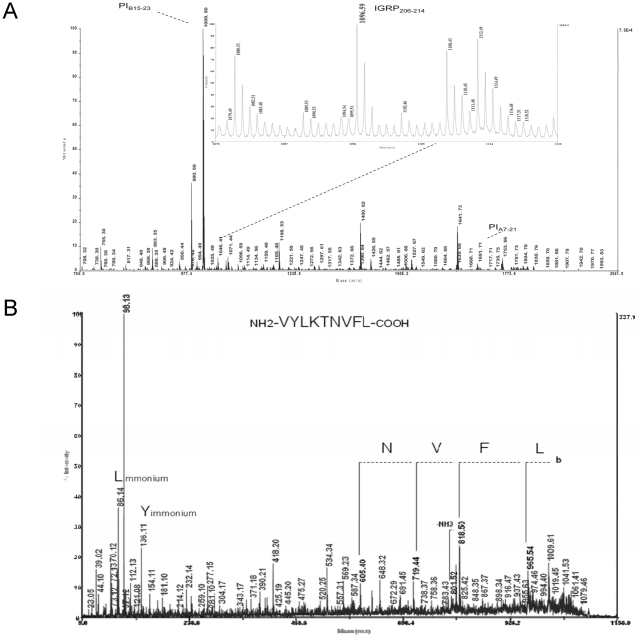
Partial sequencing of the IGRP206-214 contaminant by MS/MS.(A) MS analysis of the contaminated PIA7-21 preparation. (B) MS/MS analysis of the 1096.34 m/z compatible with the MH+ adduct of IGRP206-214.